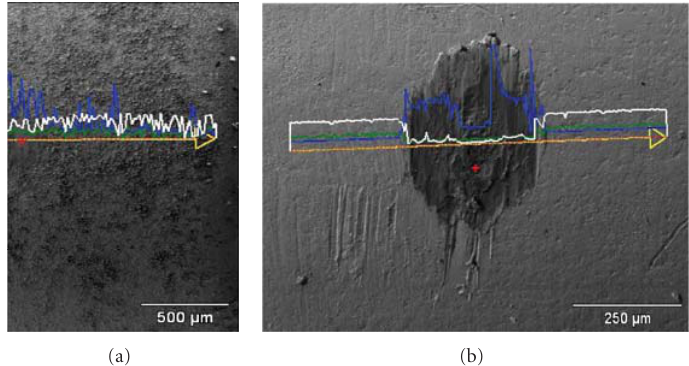
Figure 23: (a) Line scans of gold in the contact area (white line). Due to the high wear resistance of gold plating, contact survives a more than 50,000-cycle test. Average depth of wear crater was 4 μ m. (b) Line scans of gold in the contact area (white line). Due to the poor wear resistance, the gold plating is worn out after a 50,000-cycle test. Average depth of wear crater was 6 μ